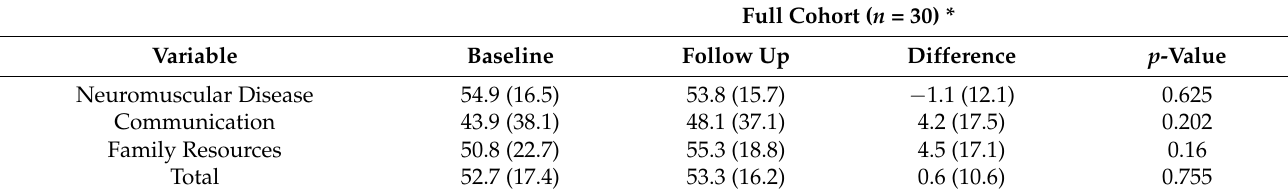
Table 3. Proxy -Report (Family Caregiver)